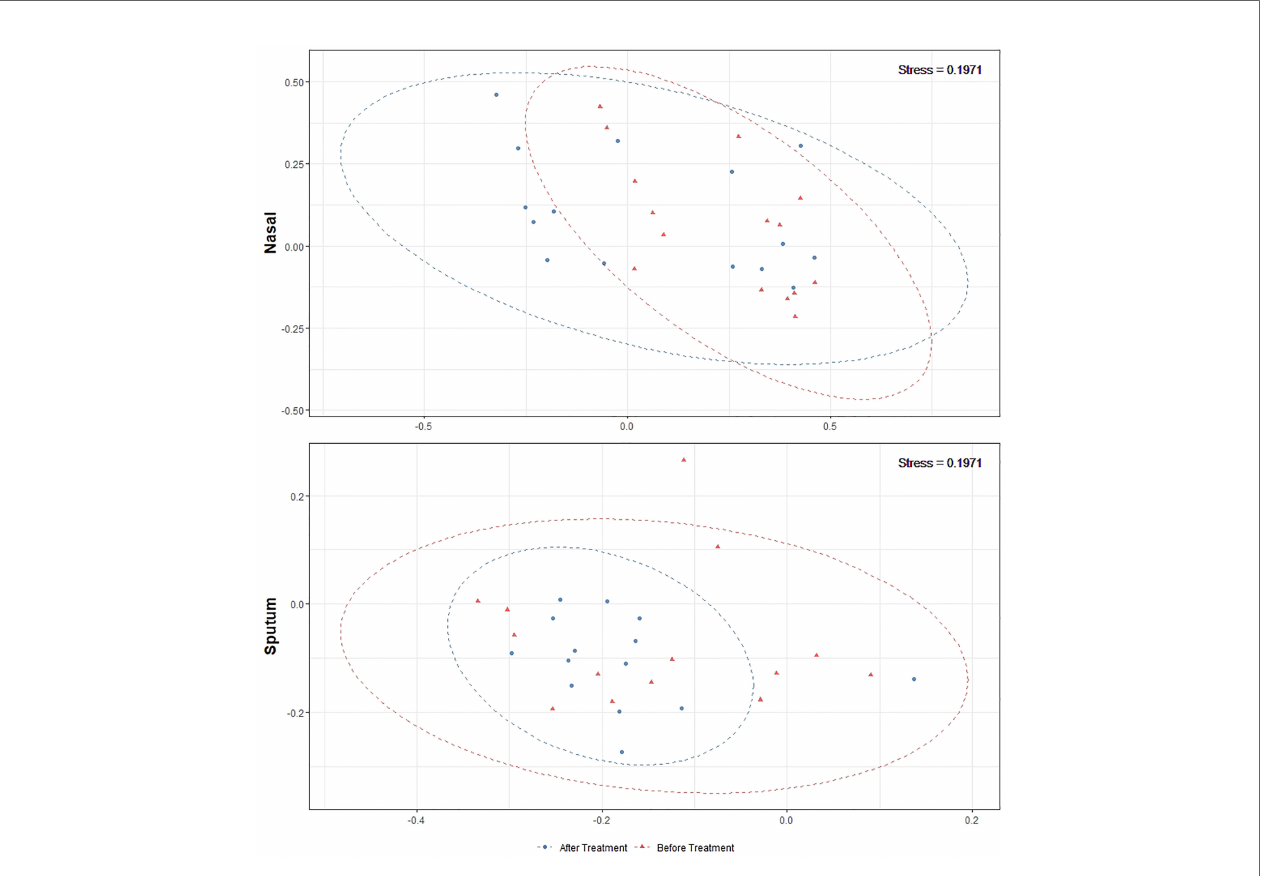
FIGURE 3 | Non-metric multidimensional scaling plots of 16S rRNA gene-based beta-diversity using the Bray-Curtis metric for bacteria in paired nasal and sputum samples across timepoints. Bacterial community dispersion was largely unchanged in nasal samples following treatment but was reduced in sputum samples. The con fi dence ellipses capture 95% of the relevant data